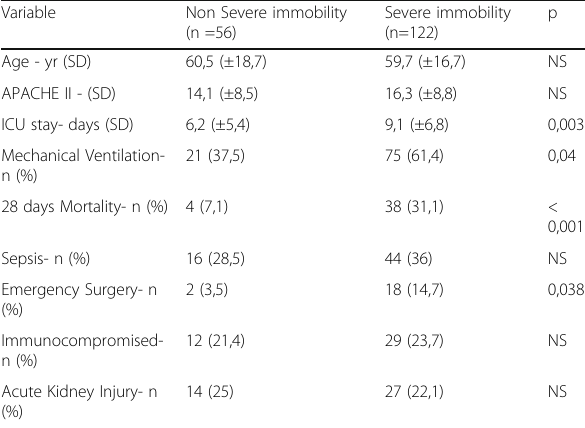
Table 1 (abstract 000926). See text for description Variable